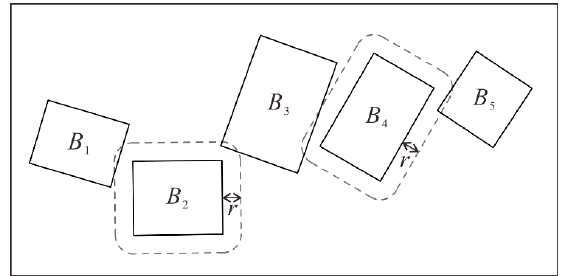
Figure 4. Conflicting blocks. r is the minimum distance threshold for detecting conflicts.